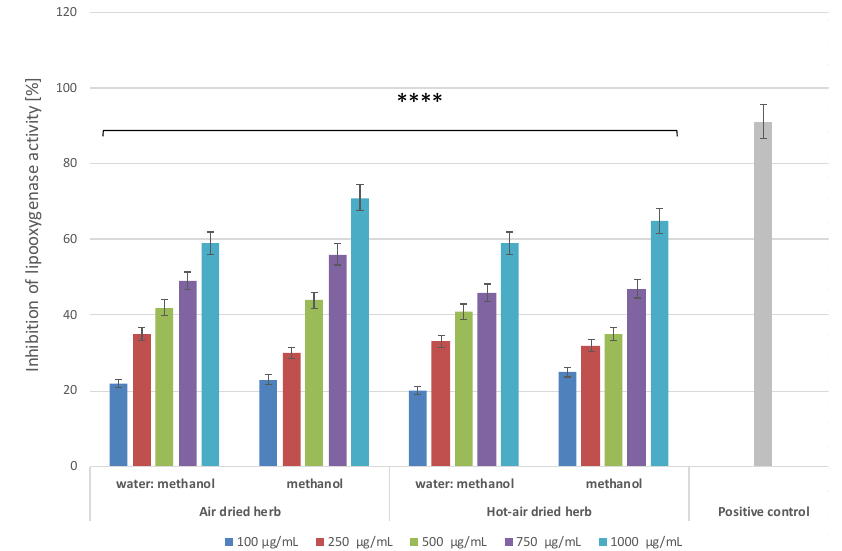
Figure 7. Lipoxygenase inhibitory activity of B. officinalis herb extracts. Data are the means of three independent experiments. **** p < 0.0001 versus the control.